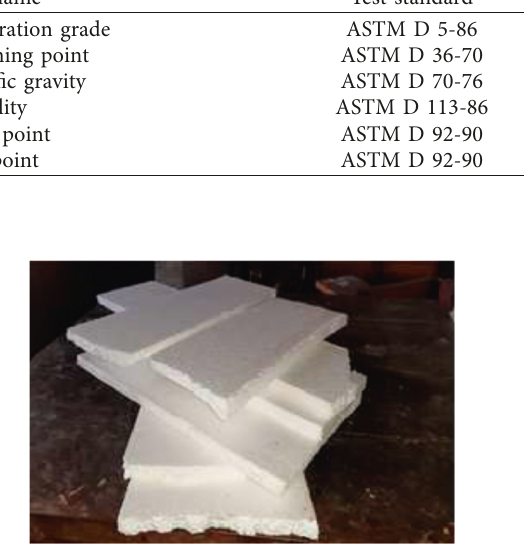
Figure 1: Waste expanded polystyrene.